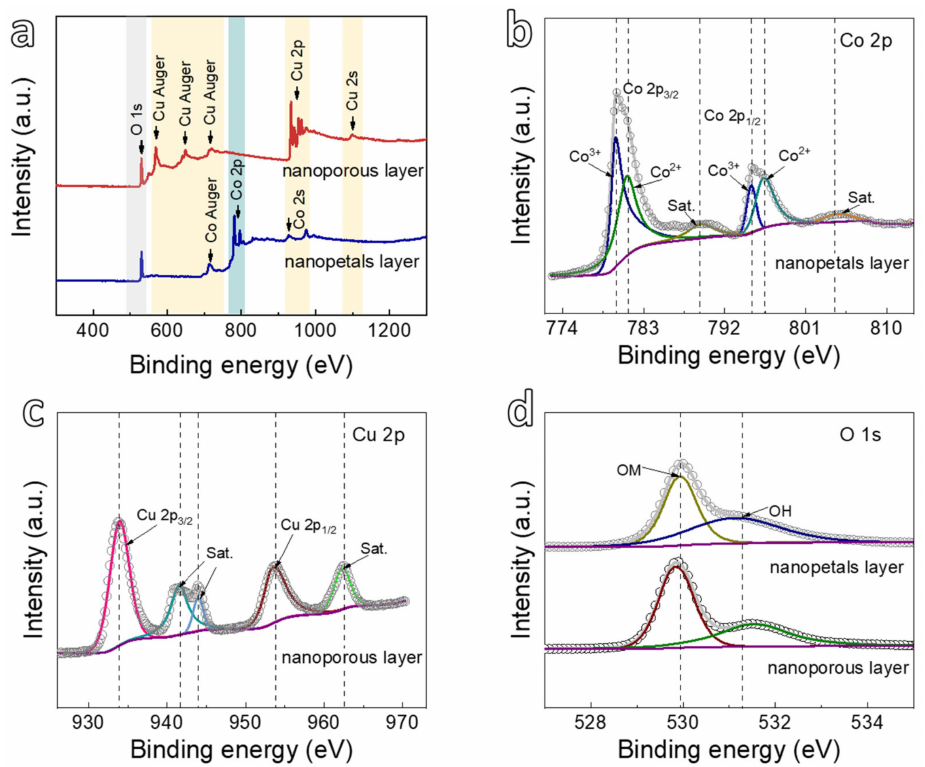
Figure 3. ( a ) XPS survey of the Co 3 O 4 nanopetals layer and CuO nanoporous layer for the Co 3 O 4 @NP- CuO composite; ( b ) The deconvolution of Co 2p spectrum of the nanopetals layer; ( c ) Cu 2p spectrum of nanoporous layer; ( d ) O 1s spectra of Co 3 O 4 nanopetals layer and CuO nanoporous layer for the Co 3 O 4